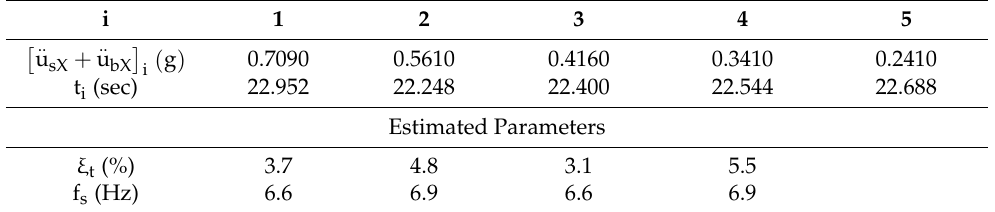
Table 4. Estimating the total damping ratio and frequency of SDOF system from free vibration results.